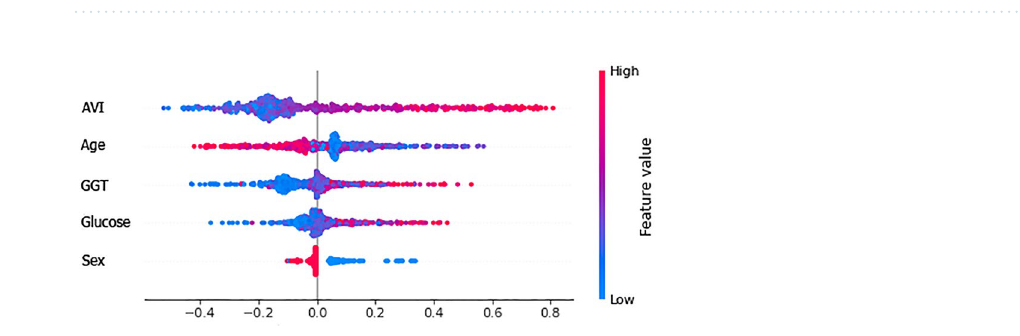
Figure 8. Global interpretation using Shapley values of anthropometric and biochemical parameters considered during test.